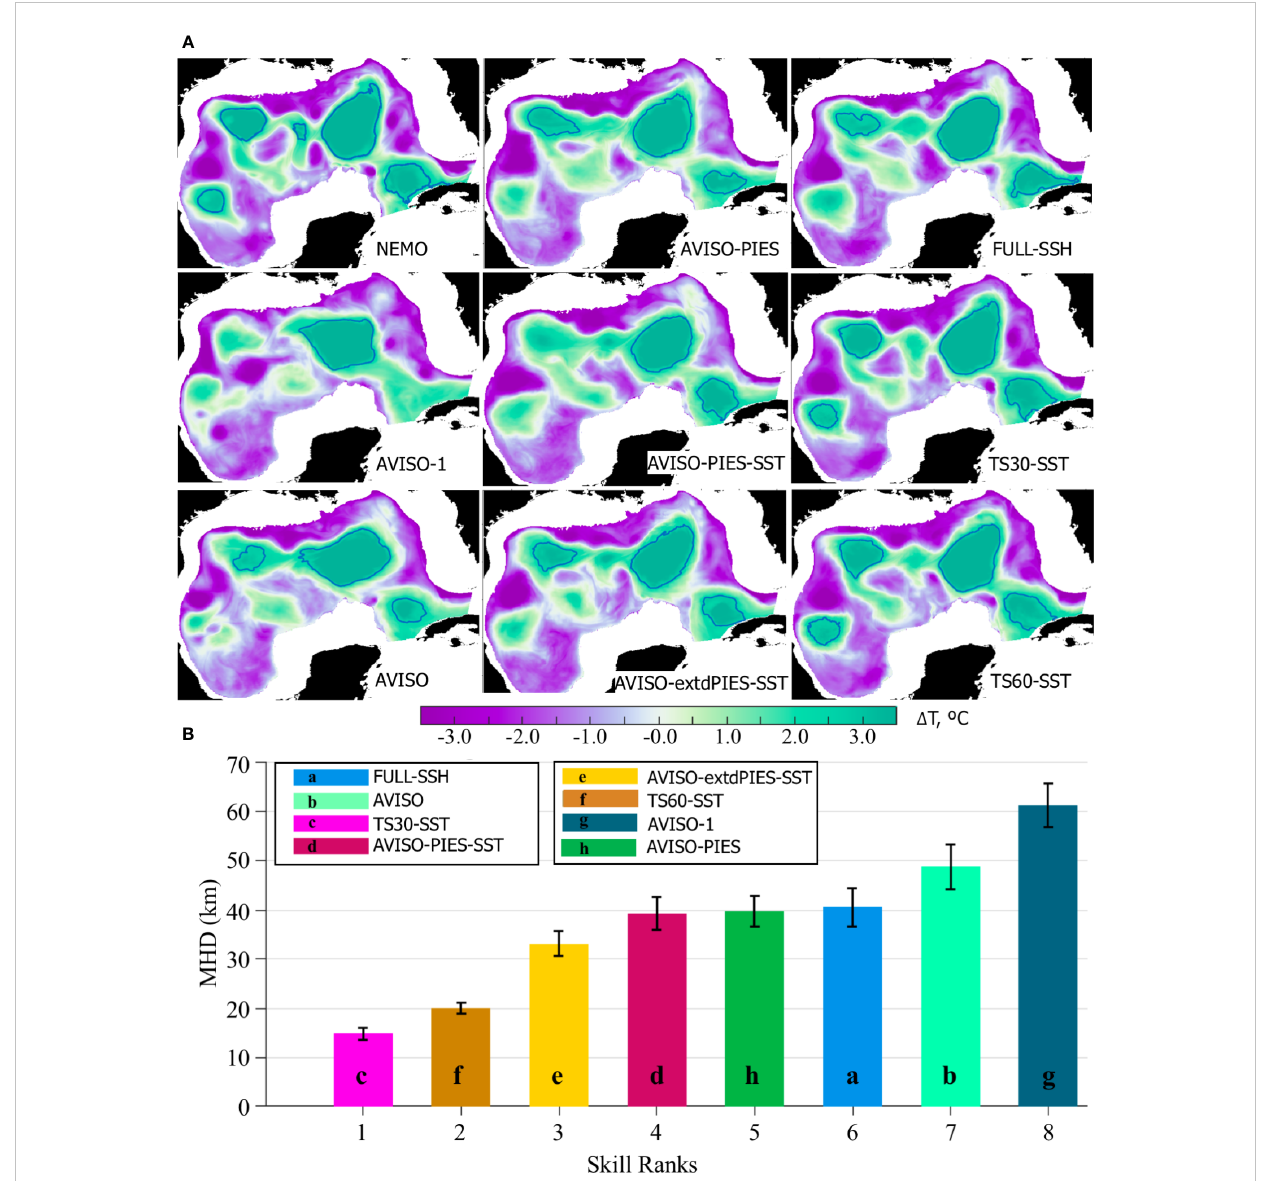
FIGURE 9 (A) Temperature anomaly ( D T) at -200 m on July 9, 2011 from the NEMO NR and OSSE analysis. The contours delineate D T=2.5 °C isoline that tracks anticyclones and the LC. (B) MHD scores computed for the 2.5 °C contours of D T at -200 m (2011-2012) derived from the OSSE analysis fi elds and the NEMO NR. The colored bars are the medians with colors corresponding to the OSSE hindcasts. The hindcasts have been ranked based on the median MHD. The vertical black lines on top of the bars indicate the